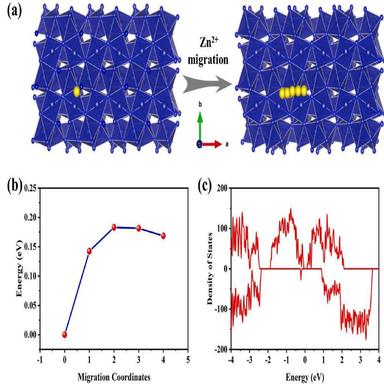
(a) Schematic diagram of the simulated migration path of Zn2+ ions across the (104) plane of V2O3. (b) Migration energy barriers of Zn2+ ions in V2O3. (c) The calculated DOS curves for V2O3.